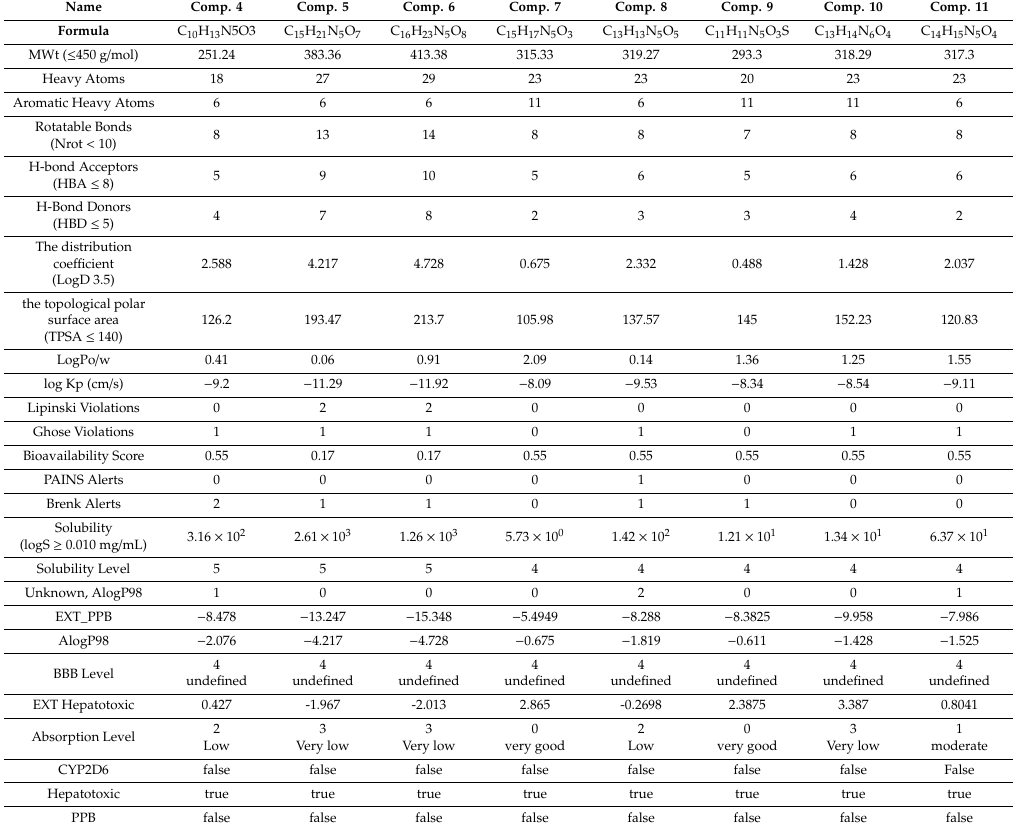
Table 5. Absorption, distribution, metabolism, and excretion (ADMET) prediction of all